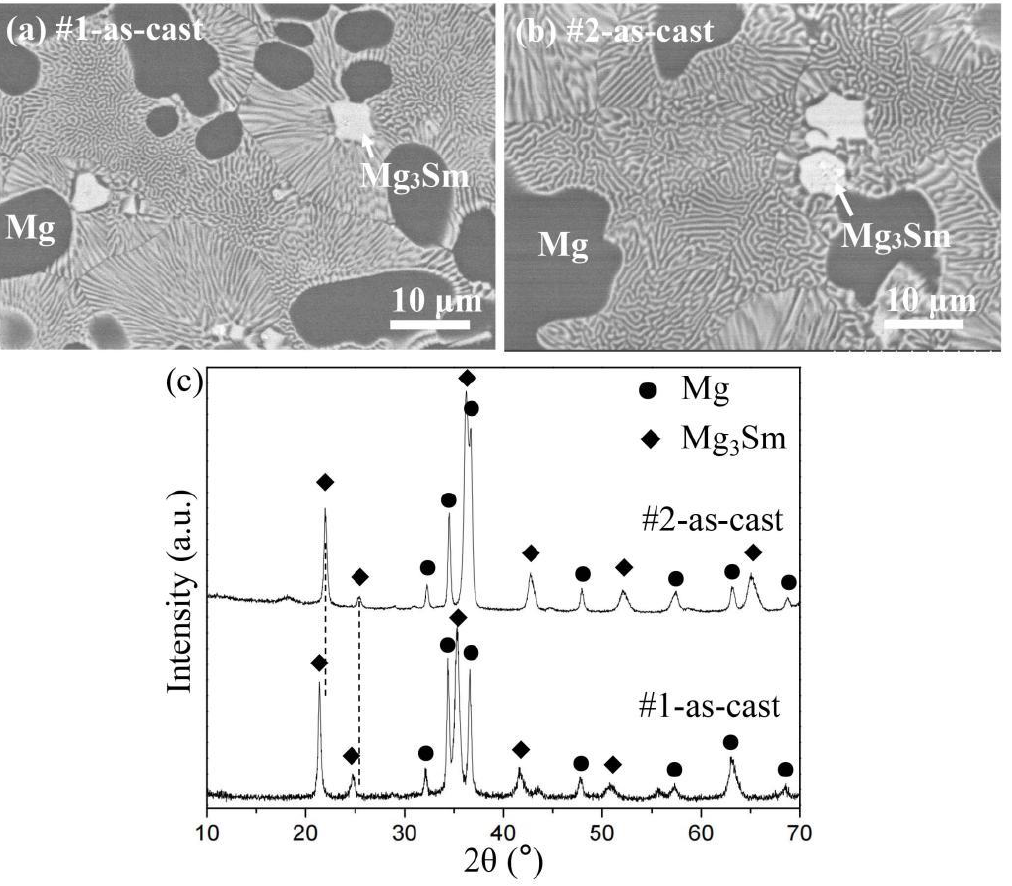
Figure 1. The microstructure of as-cast alloys #1 and #2. ( a , b ) The BSE images and ( c ) XRD patterns. Figure 2 gives the BSE images of as-cast alloys #3–#8. Four phases, Mg, Mg 3 Sm, Y and τ , are observed in both as-cast alloys #3 and #4 shown in Figure 2a,b. The solubility of Zn in Mg 3 Sm phase is measured to be 49.6 at.%, which is significantly higher than that measured in as-cast alloys #1 and #2. The Sm content in the Y phase (Mg 62 Zn 31 Sm 7 ) is slightly lower than that reported by Drits et al. [17]. A small particle phase, denoted as τ here, is found to be embedded in the Y phase. The composition of τ is determined to be Mg 36 Zn 50 Sm 14 , but its structure is still unknown. In addition, this newly found phase is no longer detectable in subsequently annealed alloys. As displayed in Figure 2c,d, primary Mg dendrites and secondary coarse Y phase are located in the grain boundary in as-cast alloys #5 and #6. The massive Y phase in alloy #7 (see Figure 2e) suggests that it is the primary phase and is surrounded by subsequently formed Mg dendrites. The as-cast alloy #8, shown in Figure 2f, is composed of primary Z phase, MgZn 2 , MgZn and Mg 7 Zn 3